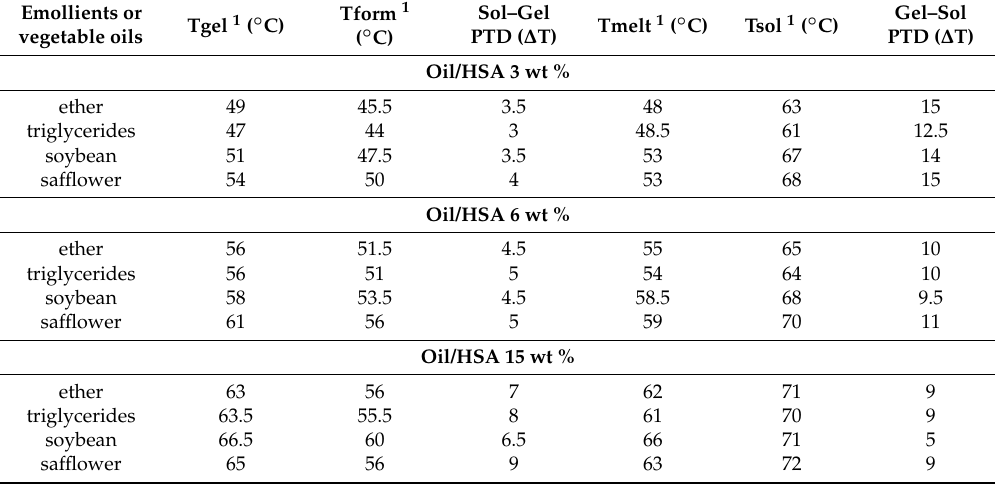
Table 1. Phase transition parameters of organogels obtained from emollients (dicaprylyl ether, capric/caprylic triglycerides) or vegetable oils (soybean, safflower) and 3, 6, and 15 wt % of HSA, respectively. PDT: phase transition